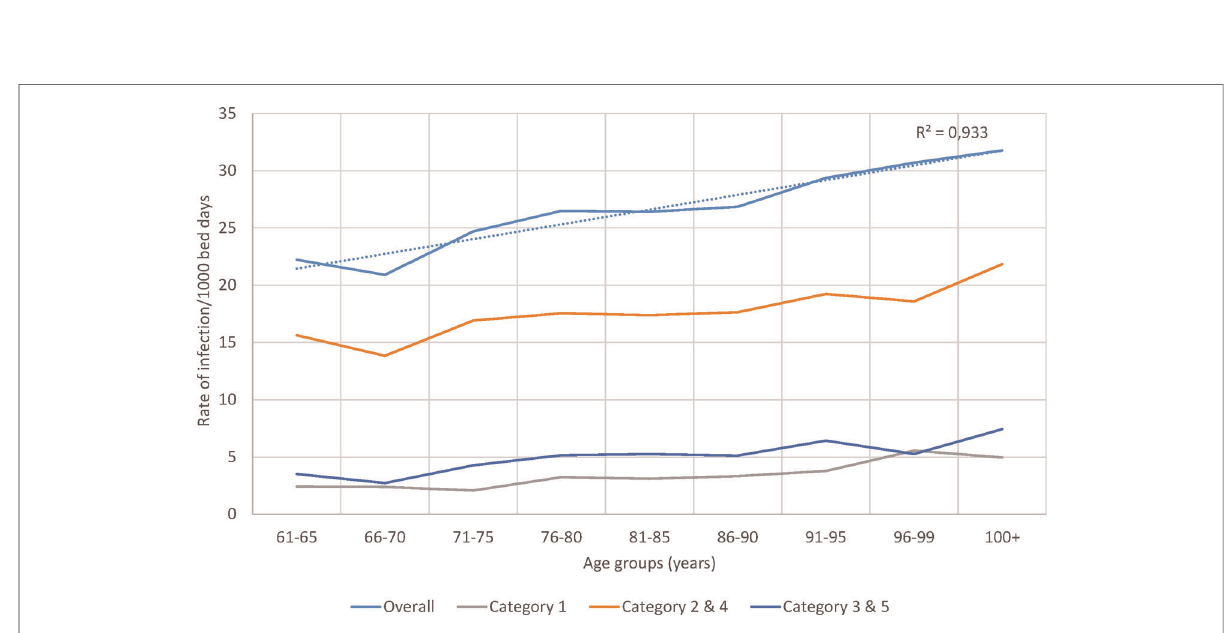
infection categories for the Geriatric ward and the Pulmonology ward, respectively. In the Geriatric ward, the curve for primary infection was furthest to the left ( Figure 9A ), indicating that number of hospitalization bed-